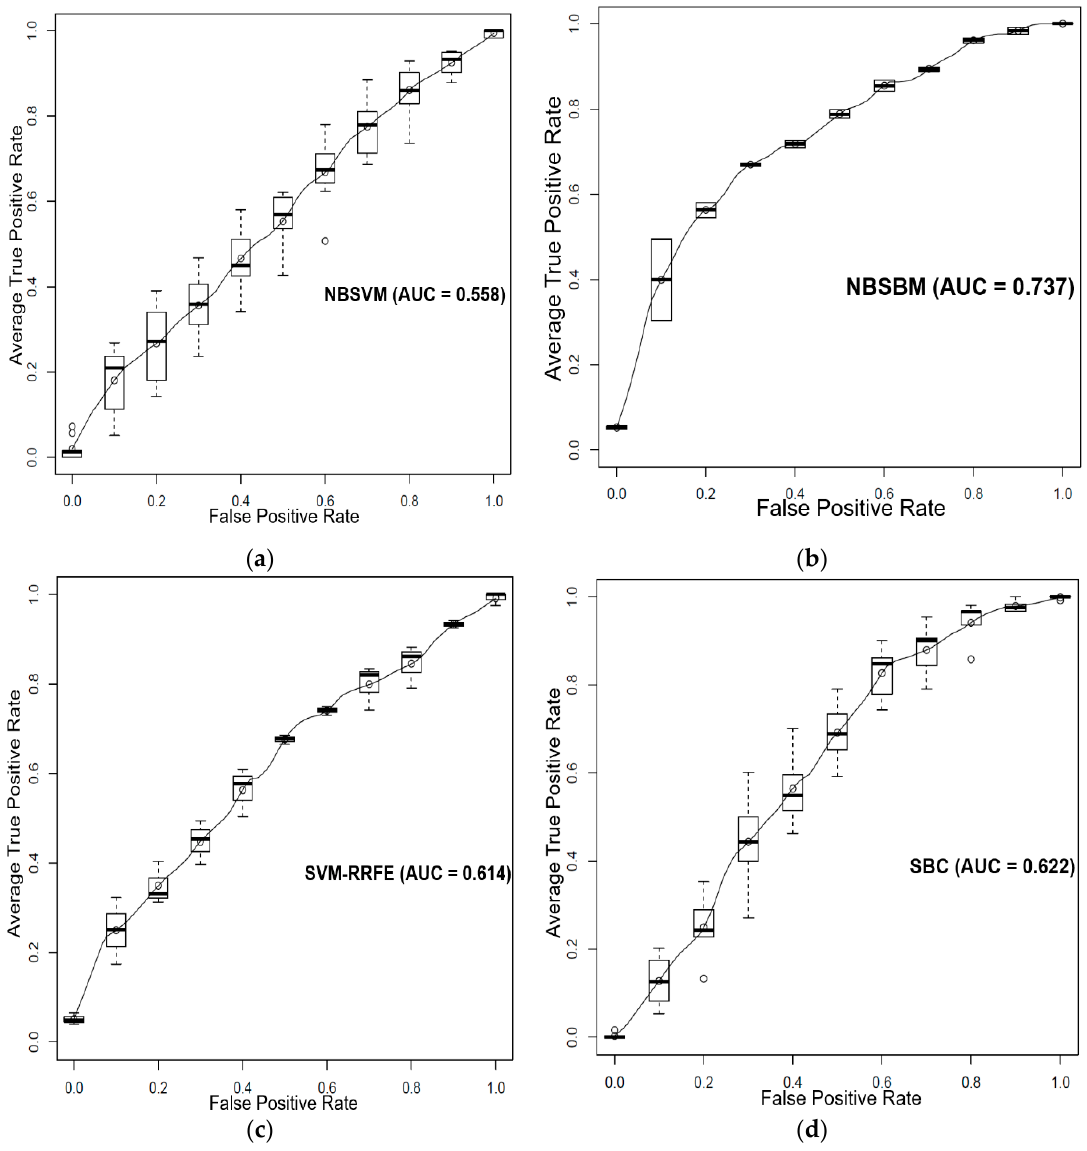
Figure 2. Comparison performance of the NBSBM with other methods in terms of average (mean) operating characteristic (ROC) curve (5-fold cross-validation and 5-repeats) and AUC value. The boxplot indicates the variation around the average ROC curve and reports the median and the interquartile range. ROC curves of ( a ) network-based SVM, ( b ) the proposed approach, ( c ) SVM-RRFE, and ( d ) sparse Bayesian classifier (SBC) to predict the response of estrogen receptor-positive breast cancer patients to Tamoxifen.